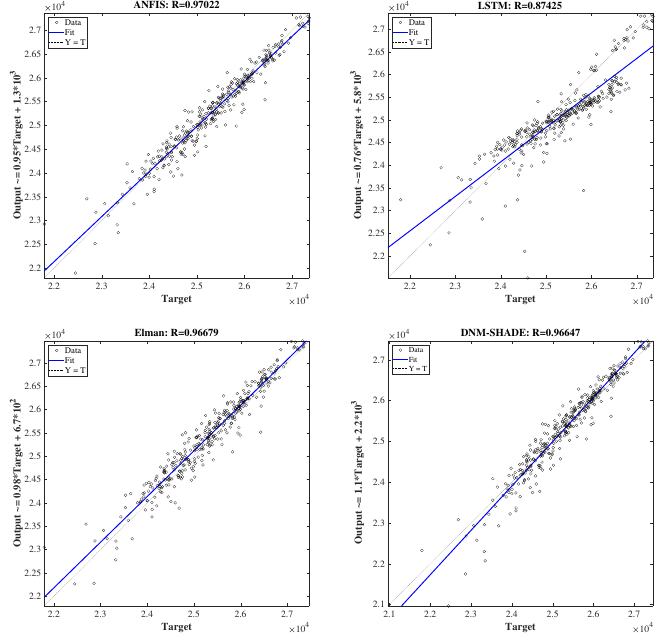
Figure 7. Correlation coefficient graphs of the top four models on DJIA.